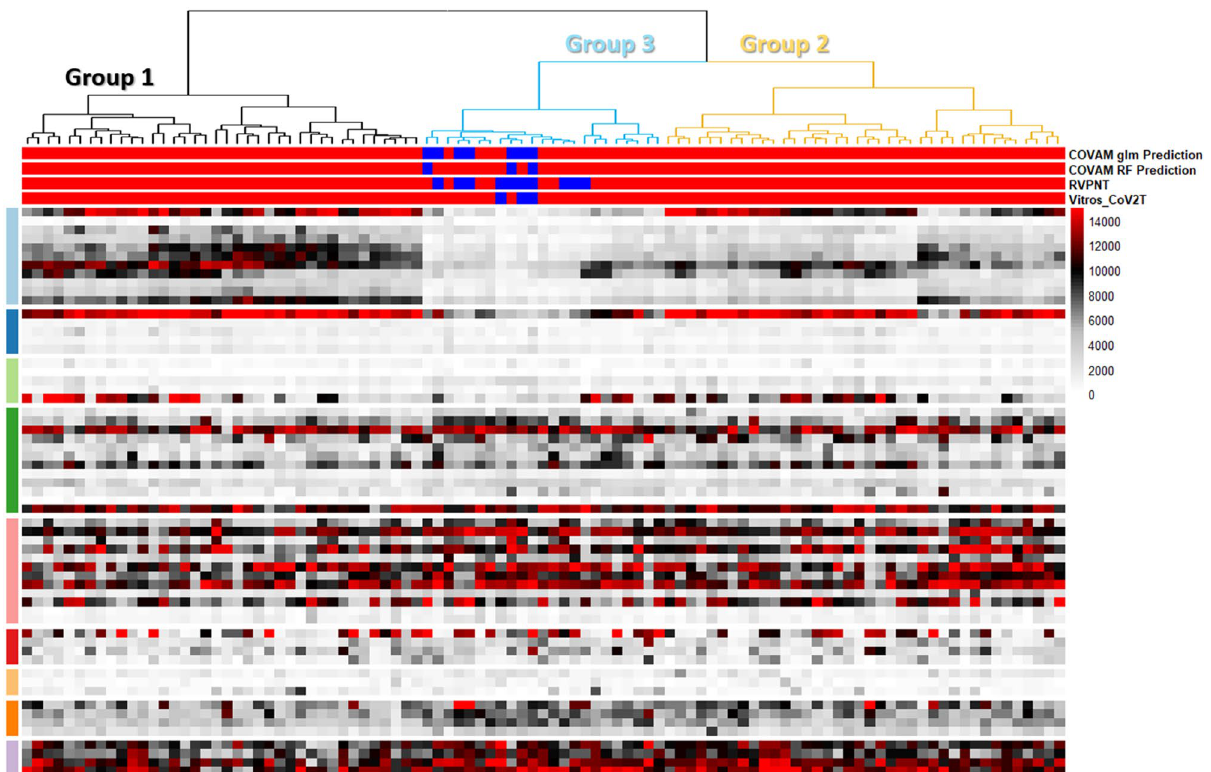
Figure 1. IgG COVAM reactivity heatmaps of 99 sera from recovered coronavirus convalescent cases. The heatmaps show the IgG reactivity levels of patients to antigens printed onto the COVAM array. Each column is the representation of a specific specimen while each row is represented as the mean reactivity of 4 replicates of each antigen. The COVAM array shows clear IgG reactivity to SARS-CoV-2 antigens that are clustered into three groups. A complete list of the antigens, in the order displayed, is available in the Supplemental Table 1. This figure was generated using the R programing language, version 4.0.2 (https:// www.r- proje ct. (Fig. 4b) highlights a significant difference between subgroups 1.1 and 1.2 in reactivity against antigen S2 which is elevated in Group 1.2. Figure 5 separates Group 2 specimens into 2 subgroups (2.1 and 2.2) evident from the heatmap (Fig. 5a) and confirmed by PCA (Fig. 5c). The bar graph (Fig. 5b) highlights a significant difference between subgroups 2.1 and 2.2 against the nucleocapsid protein and S2 which are both elevated in Group 2.2). Figure 6 separates Group 3 specimens into two groups (3.1 and 3.2) evident from the heatmap (Fig. 6a) and bar graph (Fig. 6b) and confirmed by PCA (Fig. 6c). From the bar graph and heat map it is evident that the reactiv- ity of group 3 specimens is less than that of the other two groups, but the subgroup 3.2 is particularly lacking in antibodies to SARS-CoV-2 antigens. Multiplex antigen classification of CCP.